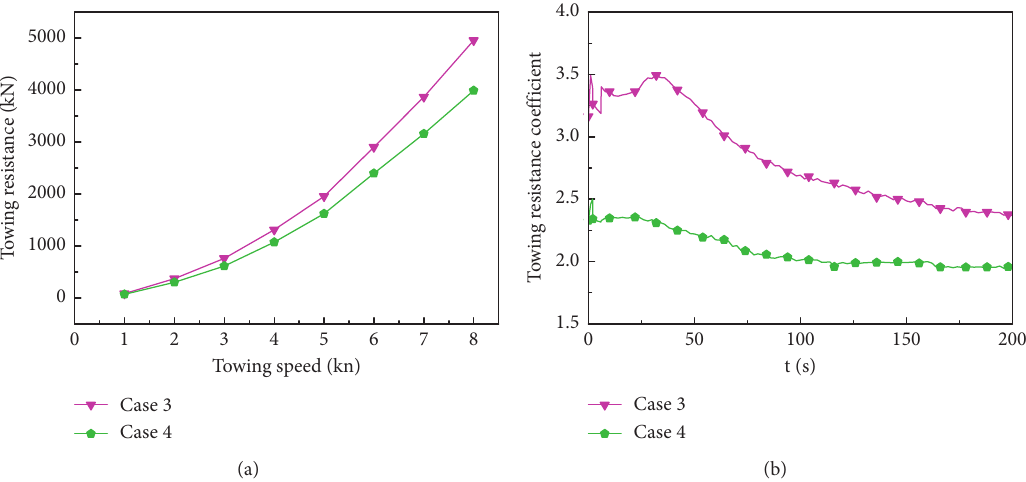
Figure 13: (a) The towing resistance of the platform at different towing speeds. (b) The towing resistance coefficient of different column cross sections at the towing speed of 4kN.